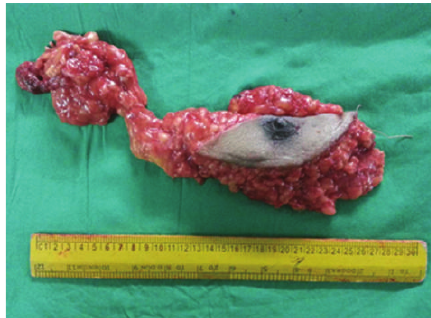
Figure 4: Specimen of the completion of modified radical mastec- tomy with ipsilateral axillary